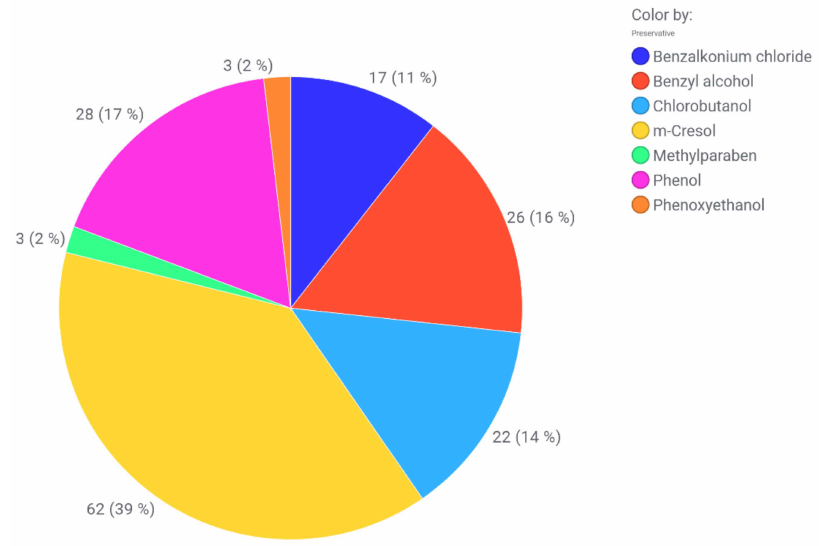
Figure 4. Preservative distribution in licensed protein, peptide, or antibody formulations. Of the currently marketed multi-dose protein formulations, m -cresol is used the most (39%) followed by phenol (17%). This is mainly because they are the preservative of choice in insulin formulations where they were reported to stabilize the insulin hexamer. The usage of the remaining preservatives follows the order benzyl alcohol (16%), benzalkonium chloride (11%), chlorobutanol (14%), methylparaben (2%), and phenoxyethanol (2%). Note: The use of rounded percent values results in a total of 101%.